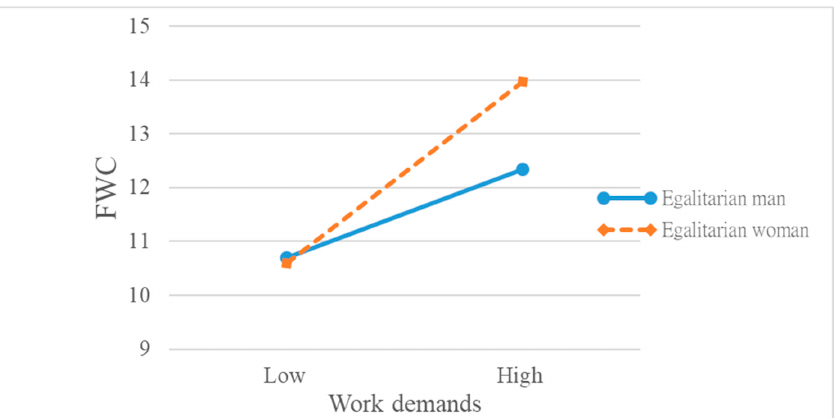
Figure 3. Interactive effect of gender and work demands on family-to-work conflict (for egalitarian men and women).